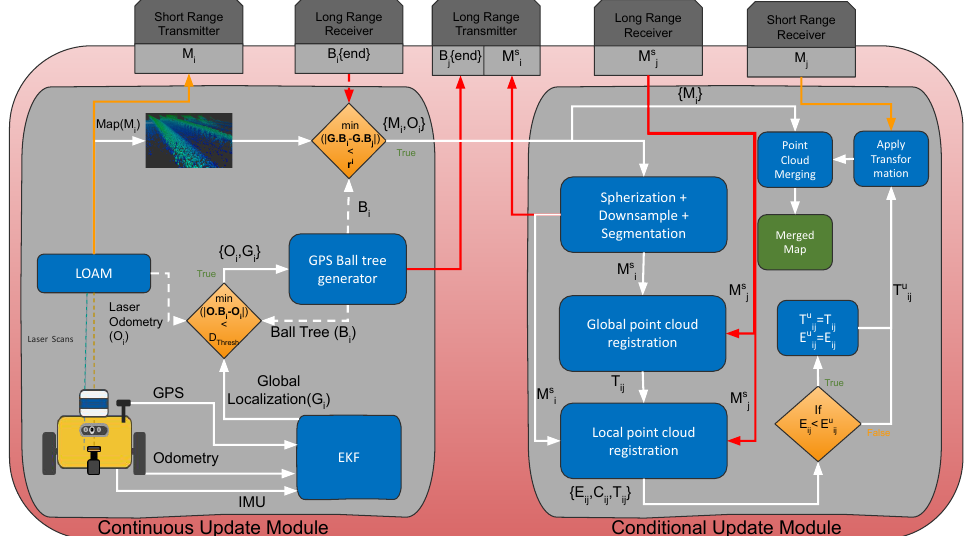
Figure 1. Proposed framework deployed in agent R i